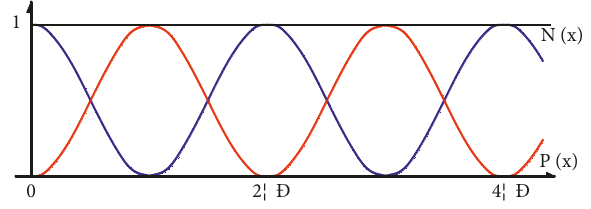
Figure 3: Yang function and negative function